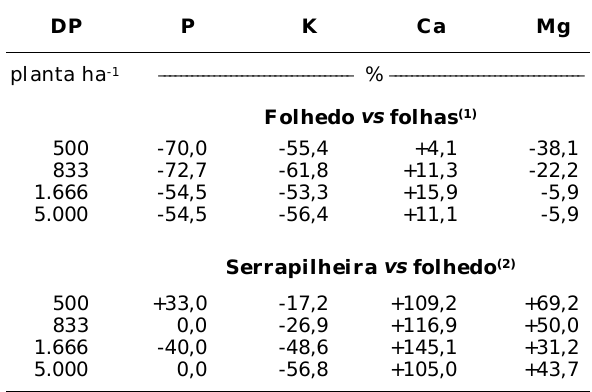
Quadro 4. Peso dos componentes secos da parte aérea de árvores de Eucalyptus grandis , com a respectiva distribuição relativa entre eles, em diferentes densidades populacionais (DP)